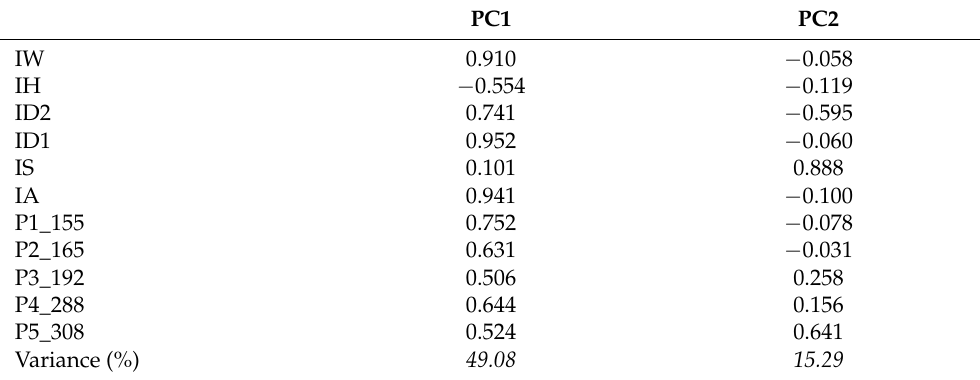
Table 5. The PCs matrix related to the bio-morphometric analysis and the selected allelic variants. PC1